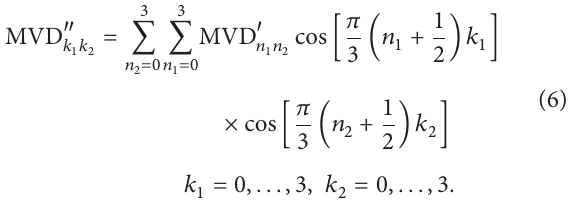
where the expression on the right-hand side represents the motion vector residual group which meets the requirement. (5) Divide these 32 MBs into two groups (16 MBs each), and then process horizontal MVDs of the